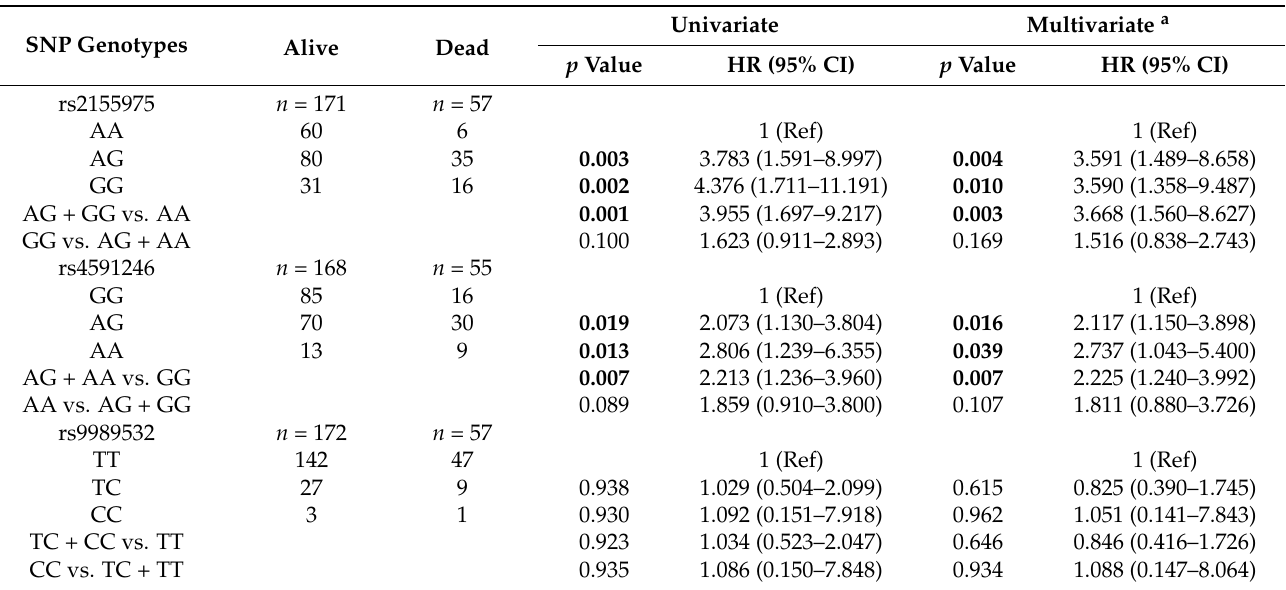
Table 2. Cox regression analysis for the association between studied SNPs and postoperative mortality of AAA patients through 5-year follow-up.